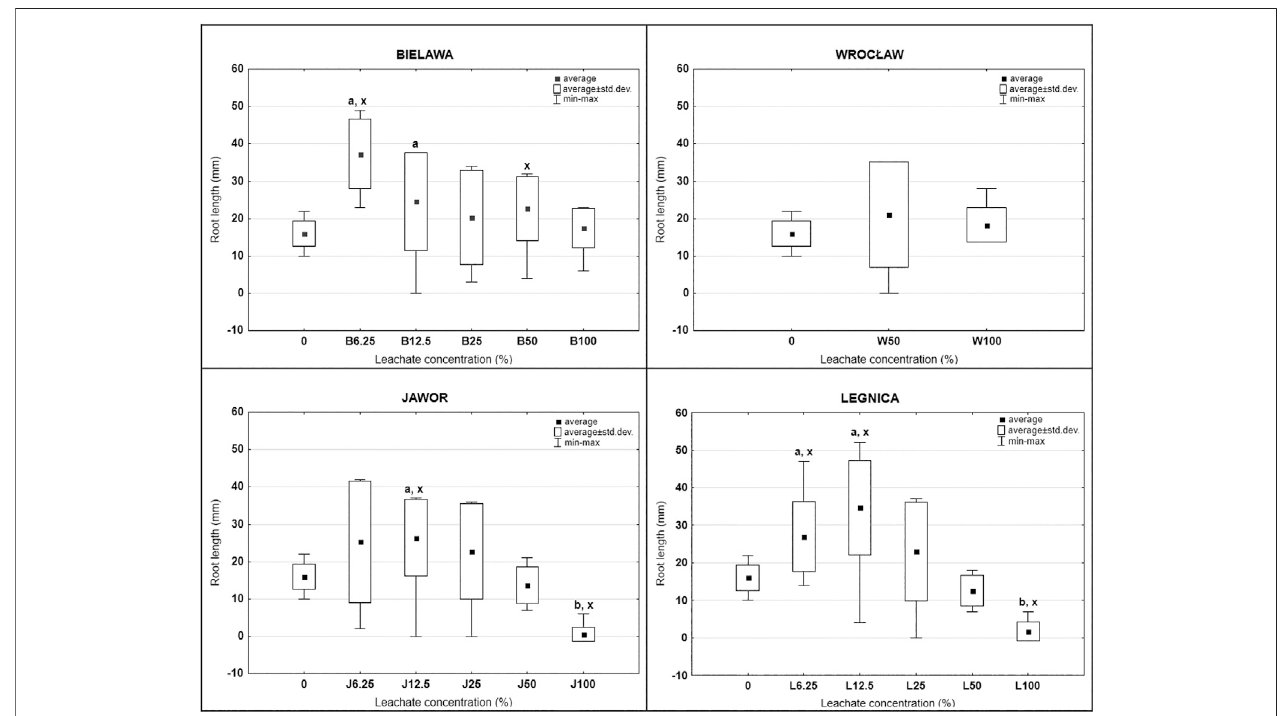
FIGURE 3 | Characteristic values (mean, standard deviation, minimum, maximum) for root length measurement results-series 09.2019.